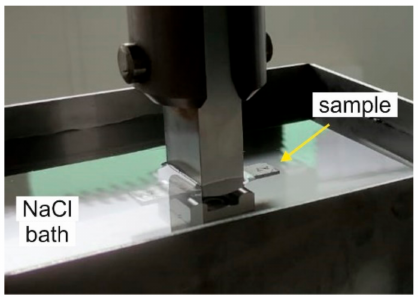
Figure 5. Corrosion fatigue 3-point bend testing